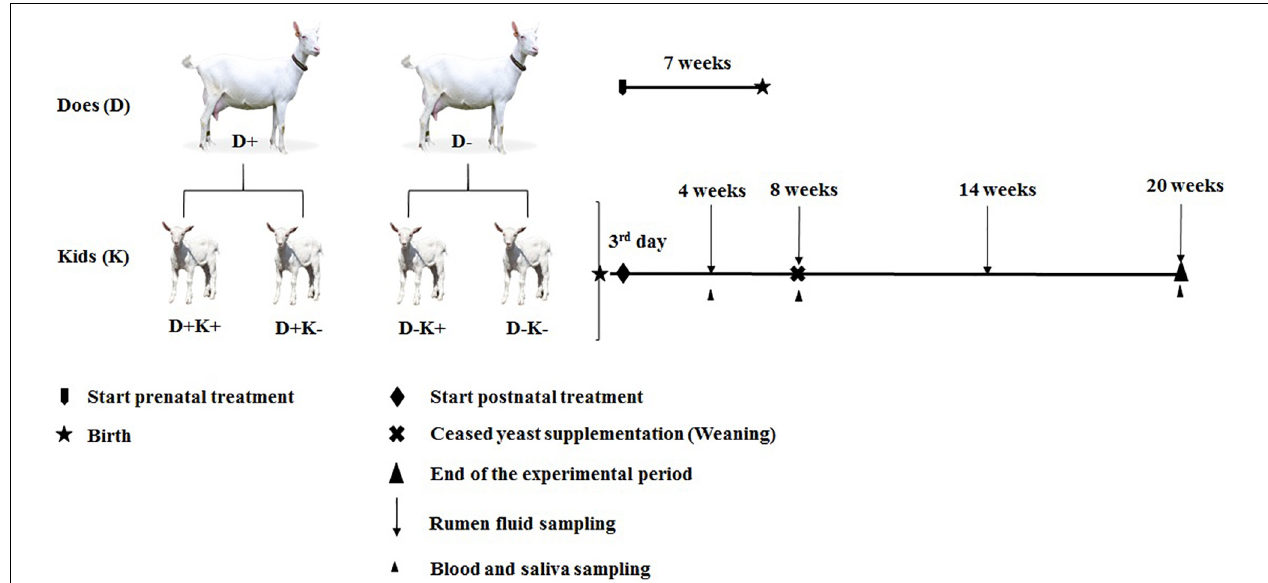
FIGURE 1 | Experimental design and sampling and data collection schedule of goat kids. D+, L. leucocephala [LL] supplemented group of does; D–, control group of does; K+, kids treated with yeast; K–, untreated kids. Four experimental groups; D+K+, yeast supplemented kids from LL supplemented group of does; D–K+, yeast supplemented kids from Control group of does; D+K–, non-supplemented kids from LL supplemented group of does; and D–K–, non supplemented kids from Control group of does.